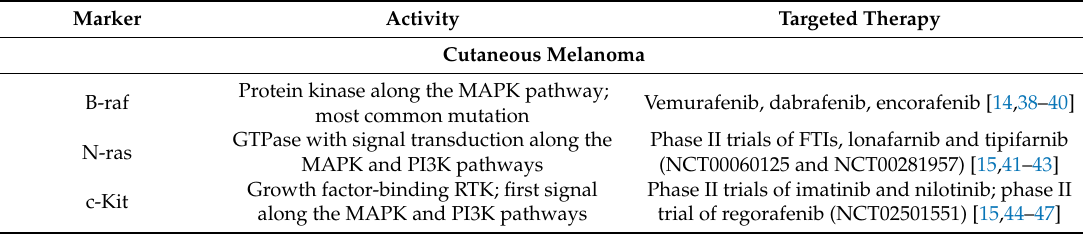
Table 2. Function of and known clinical therapies targeting melanoma